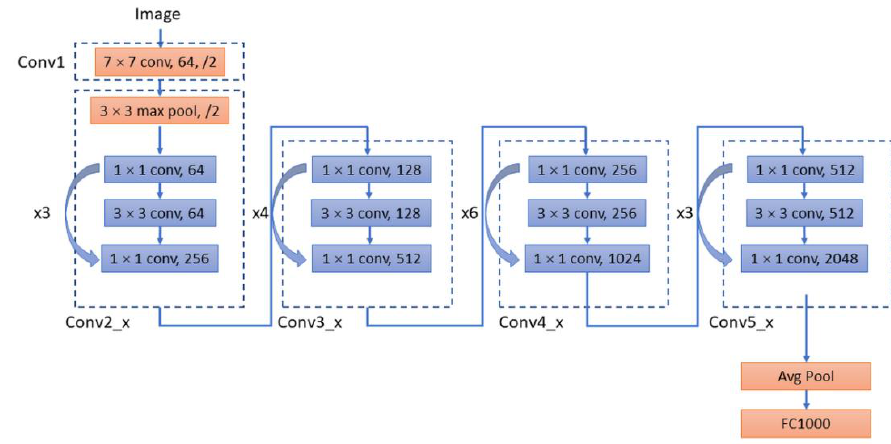
Figure 3. Network architecture of ResNet-50.